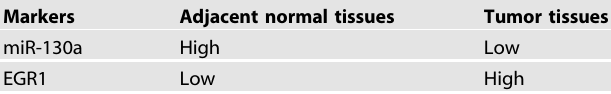
Table 2. Expression of miR-130a in tumor and adjacent normal tissues.